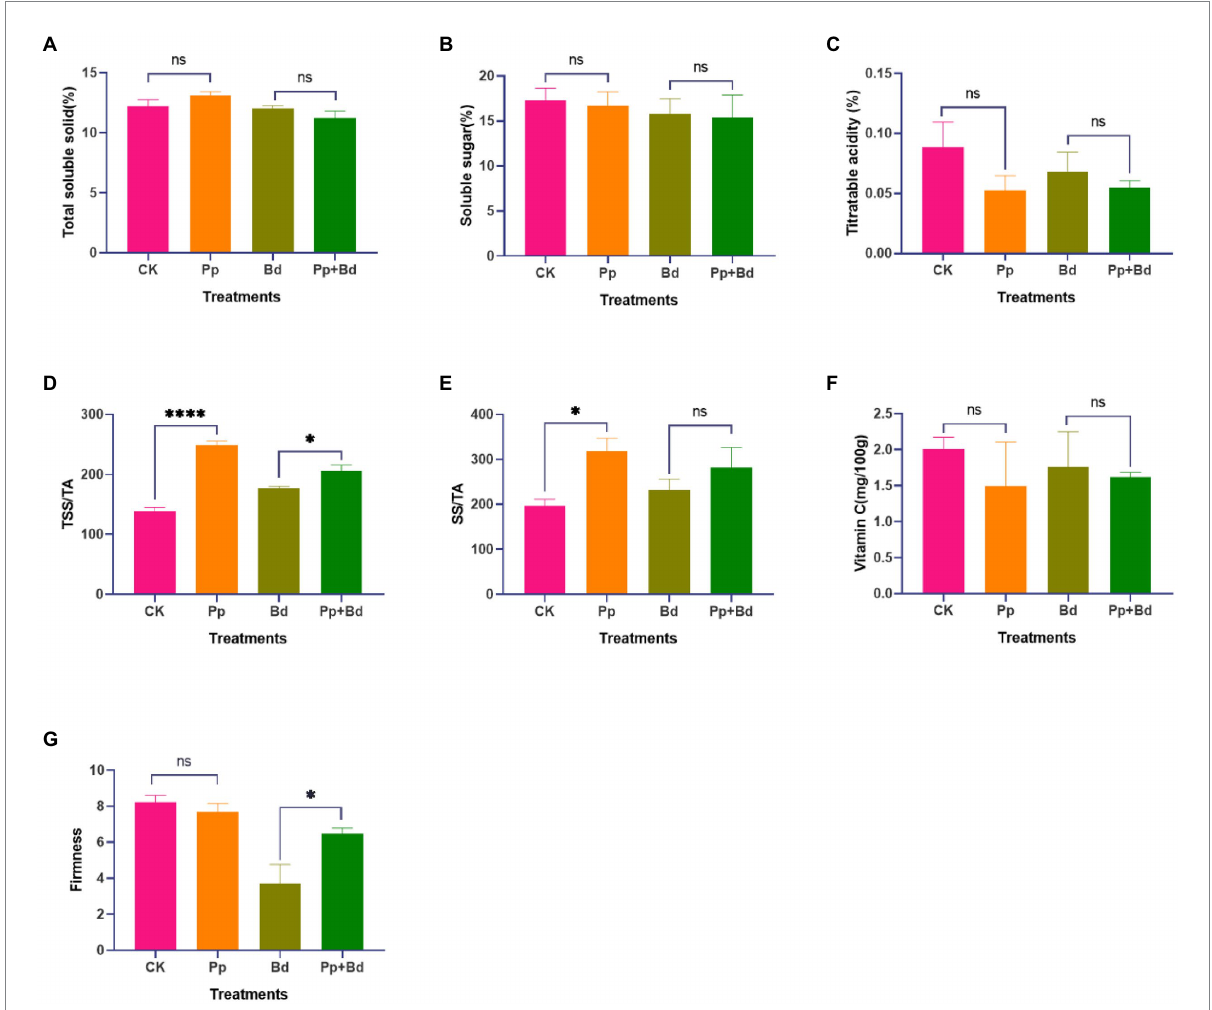
FIGURE 5 The fruit quality indexes of the apple fruits of the four treatments. Nine days later, the fruit quality indexes, including total soluble solid (TSS) (A) , titratable acidity (TA) (B) , soluble sugar (SS) (C) , total soluble solid/titrable acidity (TSS/TA) (D) , and soluble sugar/titrable acidity (SS/TA) (E) , vitamin C (VC) (F) , and firmness (G) , were different among the four treatment. * p < 0.05, **** p < 0.0001, ns p >